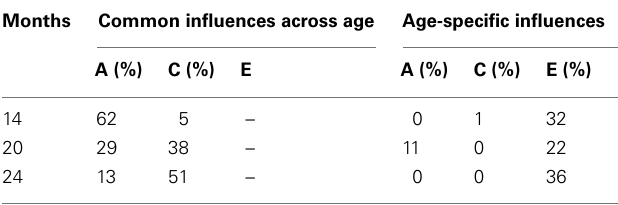
Table 6 | Percentage of variance of negative emotionality explained by genetic and environmental influences at age 14, 20, and 24months.